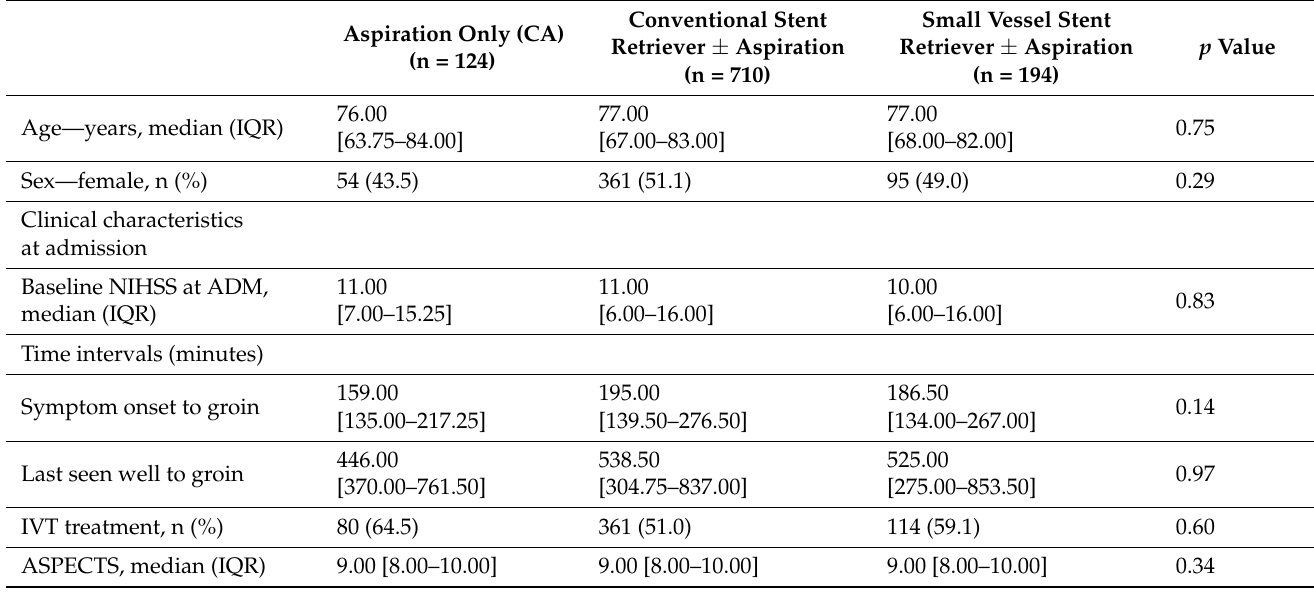
Table 3. Baseline characteristics sub-analysis MCA-M2 occlusions.